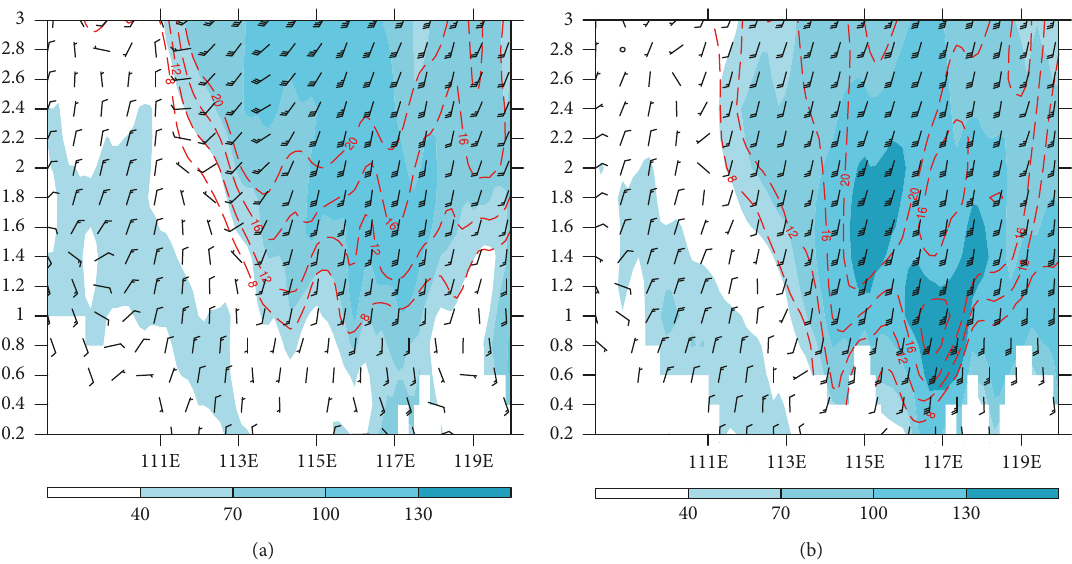
1 1 ), horizontal winds (wind barbs), and horizontal kg m s · · · − −